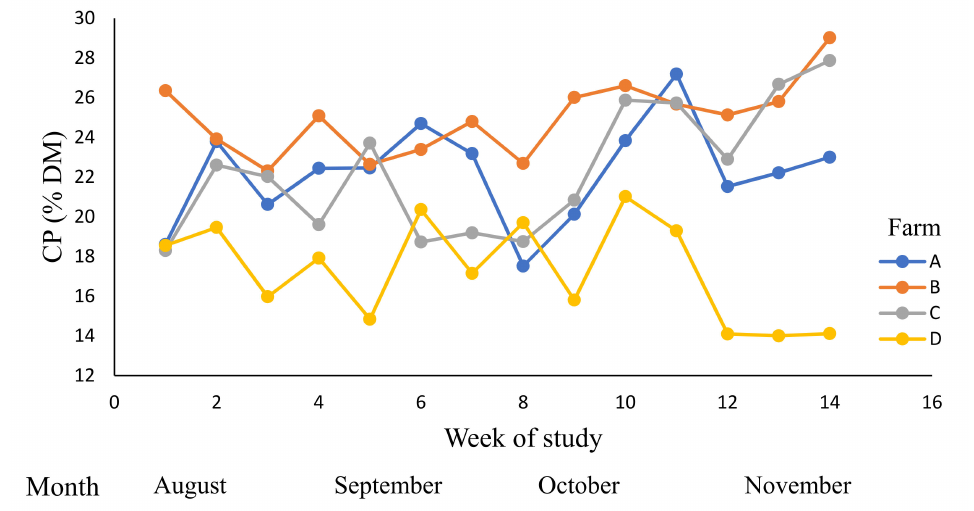
Figure 2. The variations in the crude protein (CP) content (% dry matter (DM)) across dairy farms (A–D) during winter and spring; 0–14 weeks (August to November 2019).